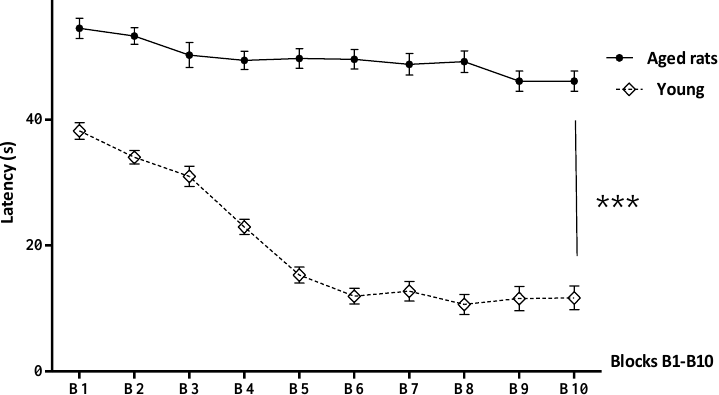
Figure 1. Latency in the MWM (mean ± SD mean are represented) to find the hidden platform during the training sessions grouped into the blocks (B). Classical training (B1–B9) and long-term contextual memory (B10). *** Significant differences between experimental groups: aged rats ( n = 45) and young ( n = 30) ( p < 0.001). Table 1. Data (mean ± SD mean) from four trials grouped in blocks (B1–B10) for the latency in the MWM and the number of crossings in the target quadrant between experimental groups.